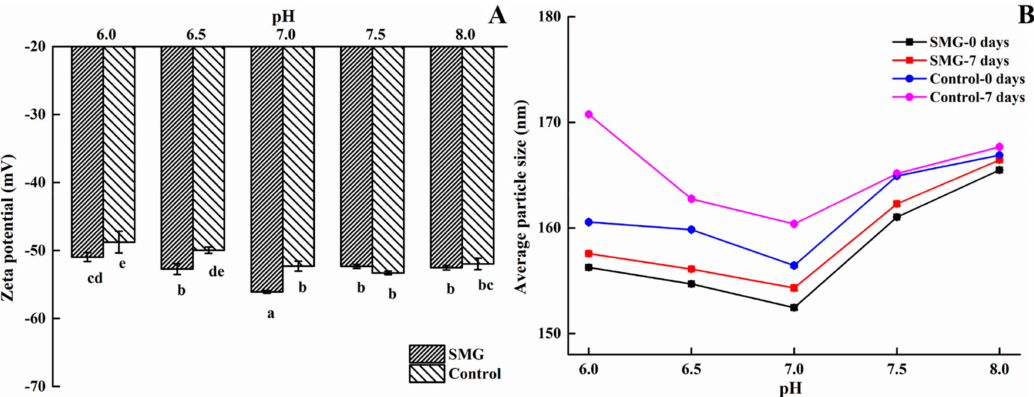
Figure 10. E ff ects of pH on the stability of SMG-stabilized emulsions. ( A ) Zeta potential of emulsions; ( B ) average particle size of